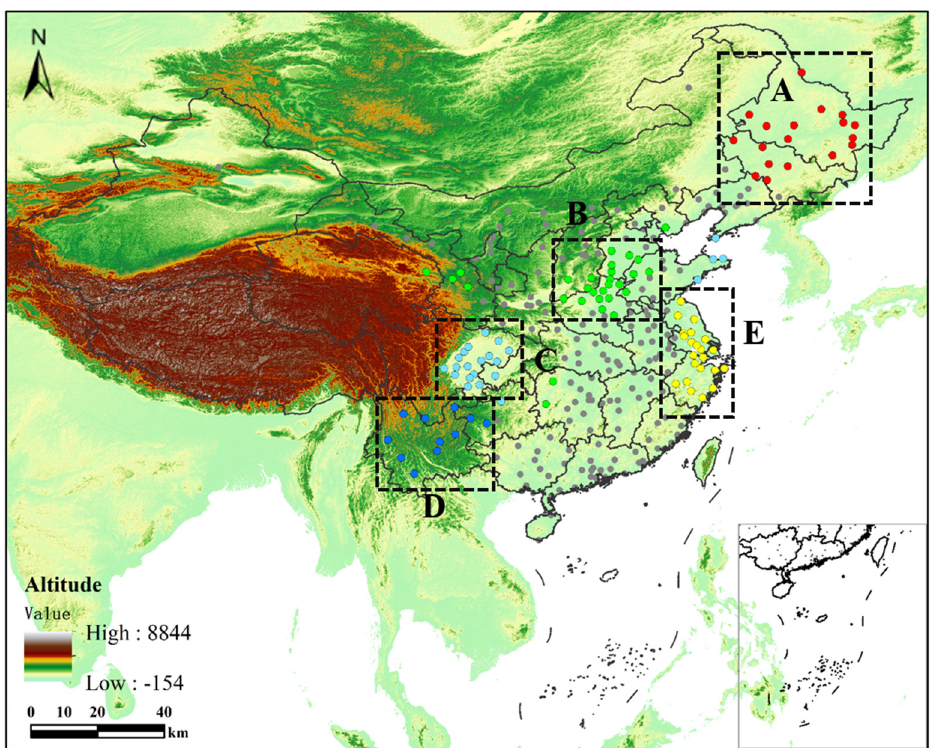
Figure 5. Typical regions with significant spatial heterogeneity associated with factors influencing PM 2.5 concentrations: region A: the northeast region (with red solid dots); region B: the Central Plains (with green solid dots); region C: the Sichuan Basin (with blue solid dots); region D: the Yunnan-Guizhou Plateau (with dark blue solid dots); region E: the lower reaches of the Yangtze River (with yellow solid dots).